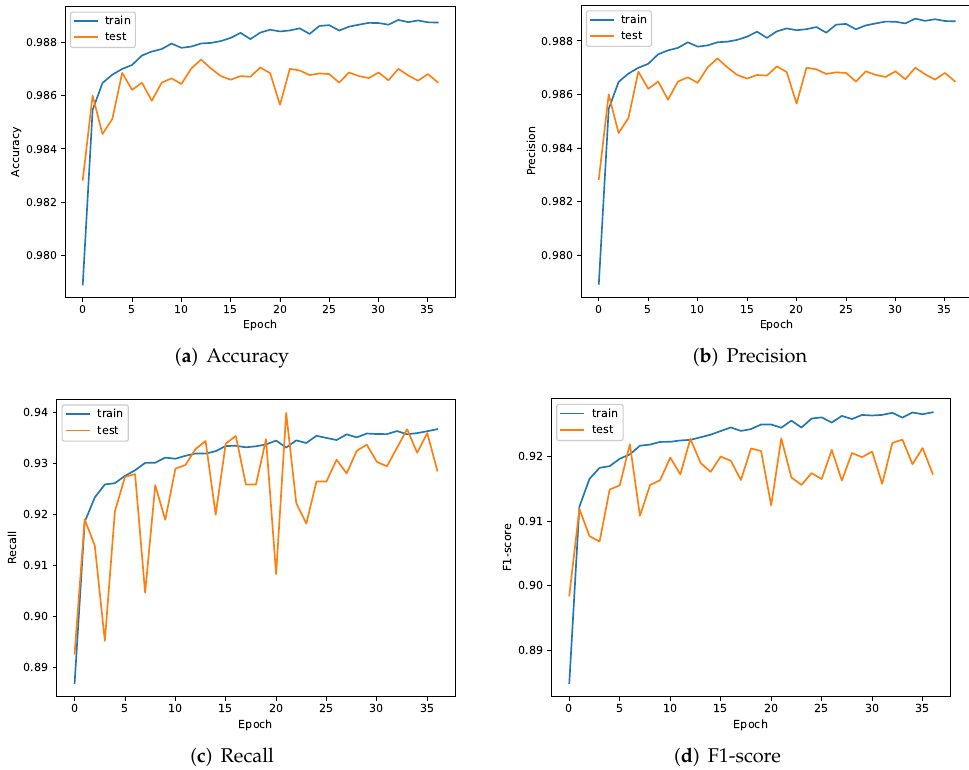
Figure 5. Metric changes during the training phase of the classification model. Table 5. Comparative experimental results between DefeatOP and DFSGraph . addOpaque4 addOpaque16 EncodeArithmetic EncodeLiterals